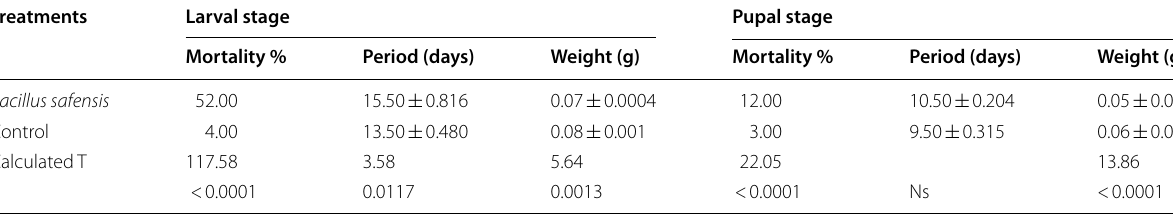
Table 4 Effect of Bacillus safensis NBRC 100820 on immature stages of spiny bollworm